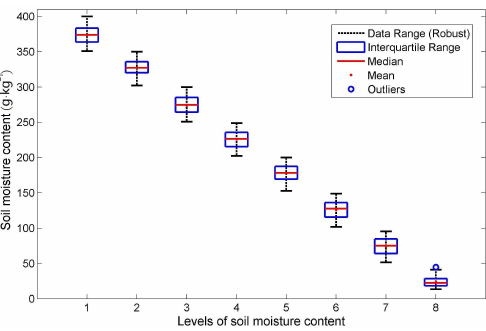
Figure 2. Eight levels of moisture content for each of 98 samples: 350–400, 300–350, 250–300, 200–250, 150–200, 100–150, 50–100, and 0–50 g · kg − 1 (air-dried).